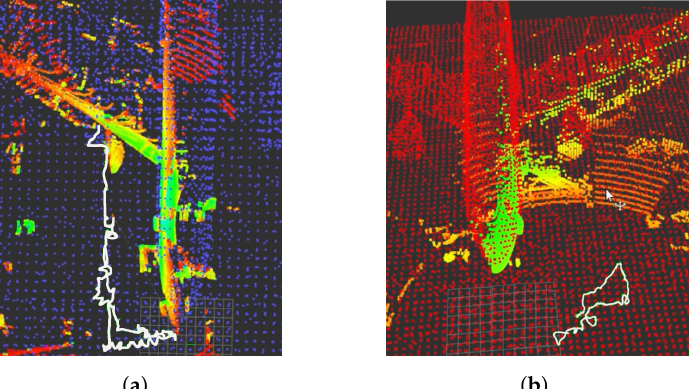
Figure 31. Performance results of the 3D localization algorithm with real data. Position estimate by the algorithm (white), 3D point cloud (green-yellow). ( a ) Path 1 test (Figure 16a). 3D graph SLAM map (blue). ( b ) Path 2 test (Figure 16b). 3D graph SLAM map